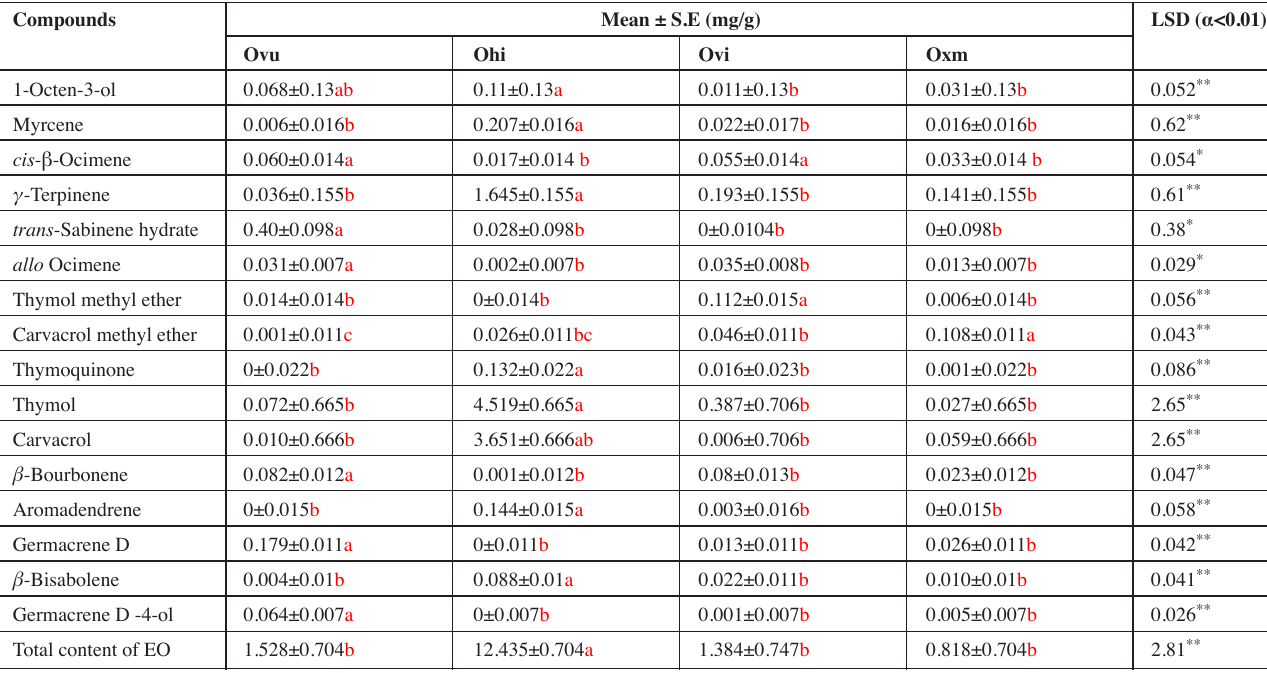
Tab. 3: Main chemical compounds in herb samples of Origanum vulgare accessions detected by using GC/MS (S.E.: standard error of the mean; Ovu: ssp. vulgare , Ohi: ssp. hirtum , Ovi: ssp. viride , Oxm: ssp. viride × majorana ) Compounds